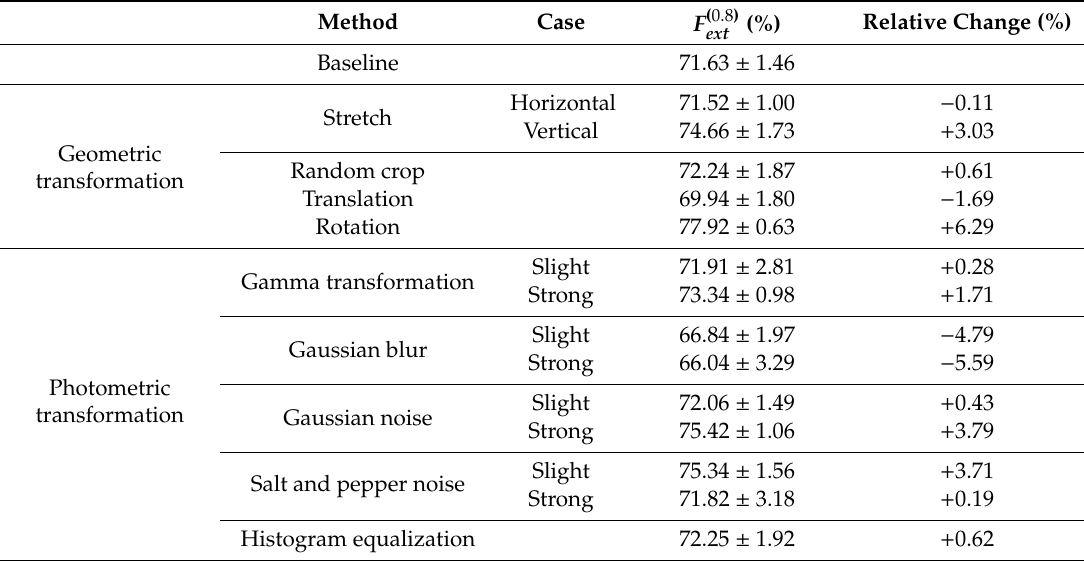
( 0.8 ) Table 1. F of di ff erent data augmentation methods of crack detection. The number of original ext images is 20, and the data augmentation factor f is